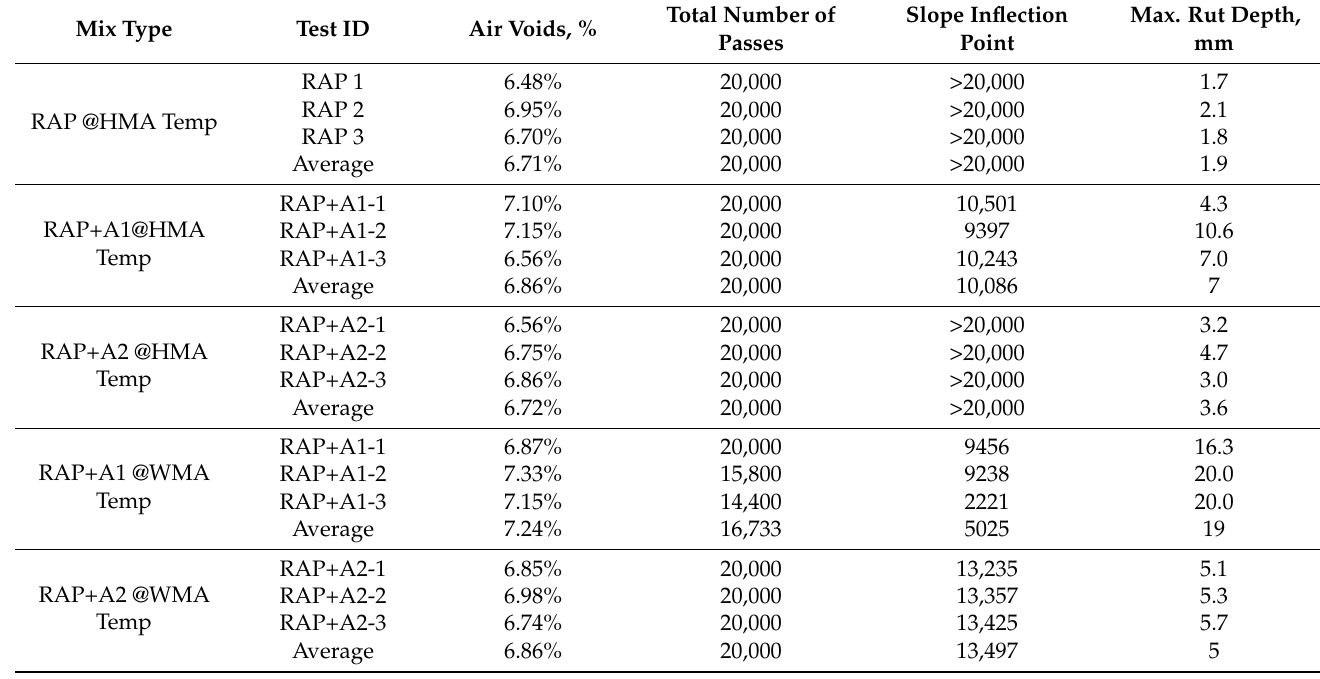
Table 4. Hamburg wheel test results for all the samples of all mixture groups.